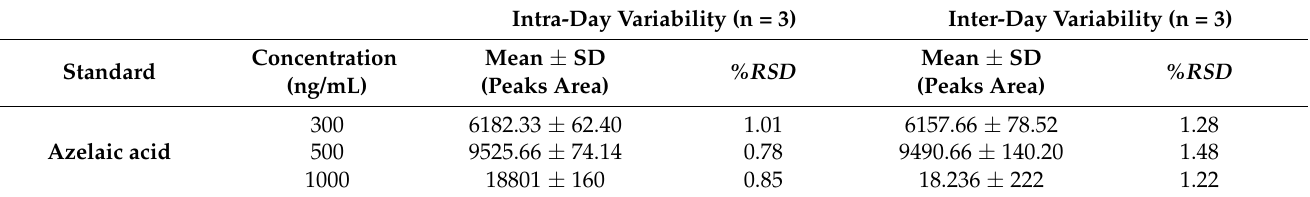
Table 1. Results of linearity regression, correlation coefficient, LOD, and LOQ for AzA.